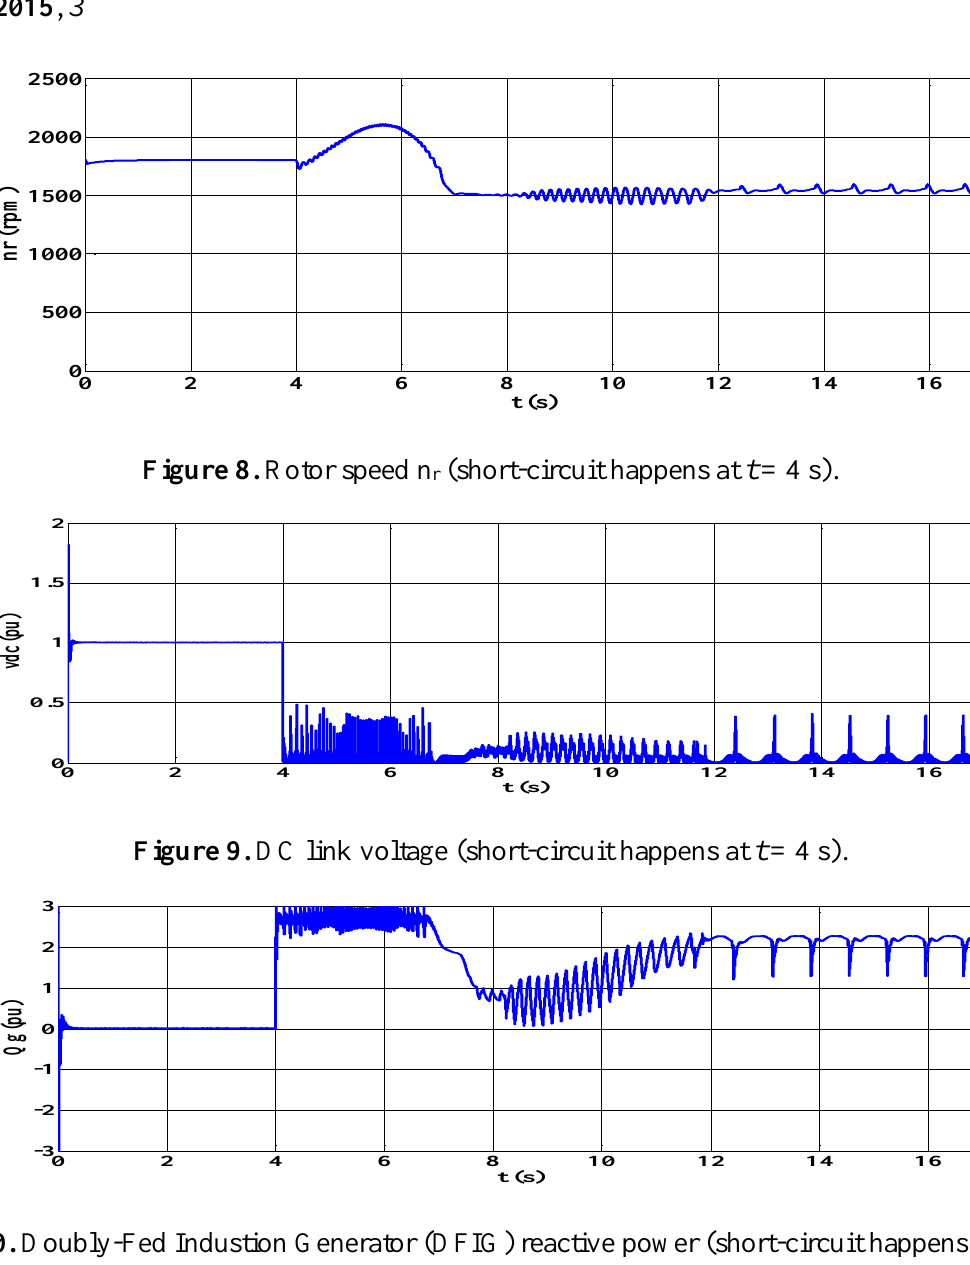
Figure 10. Doubly-Fed Industion Generator (DFIG) reactive power (short-circuit happens at t = 4 s).